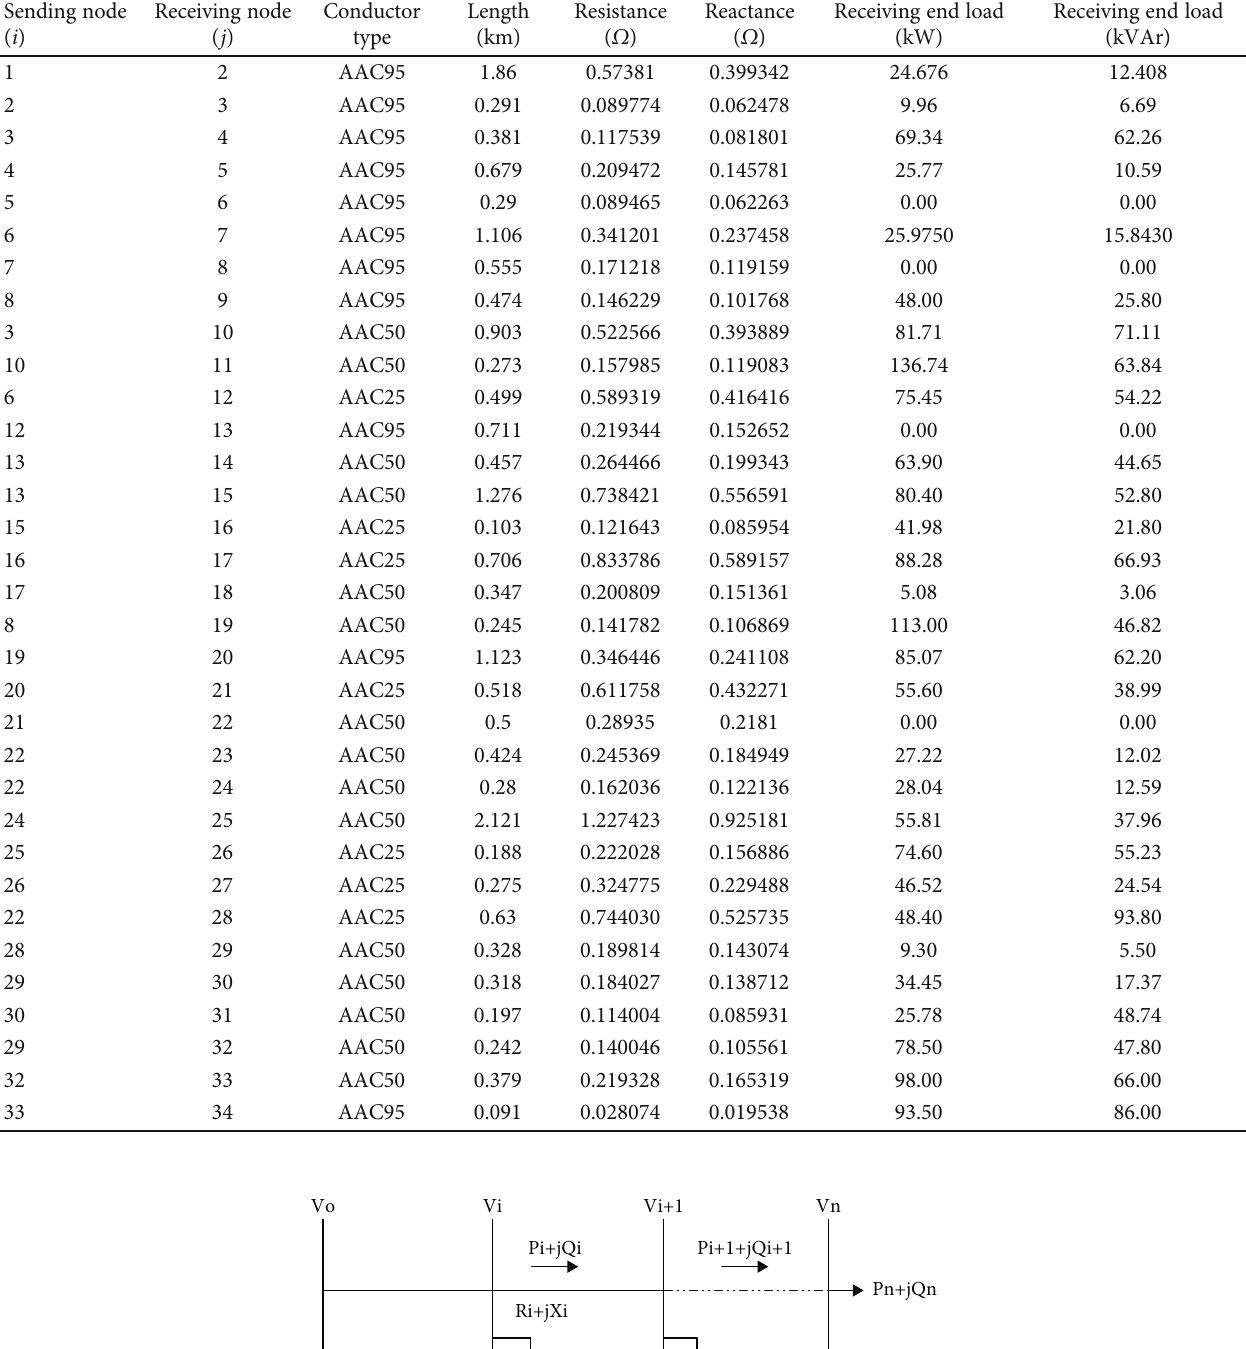
Table 1: Line and load data for BATA feeder.